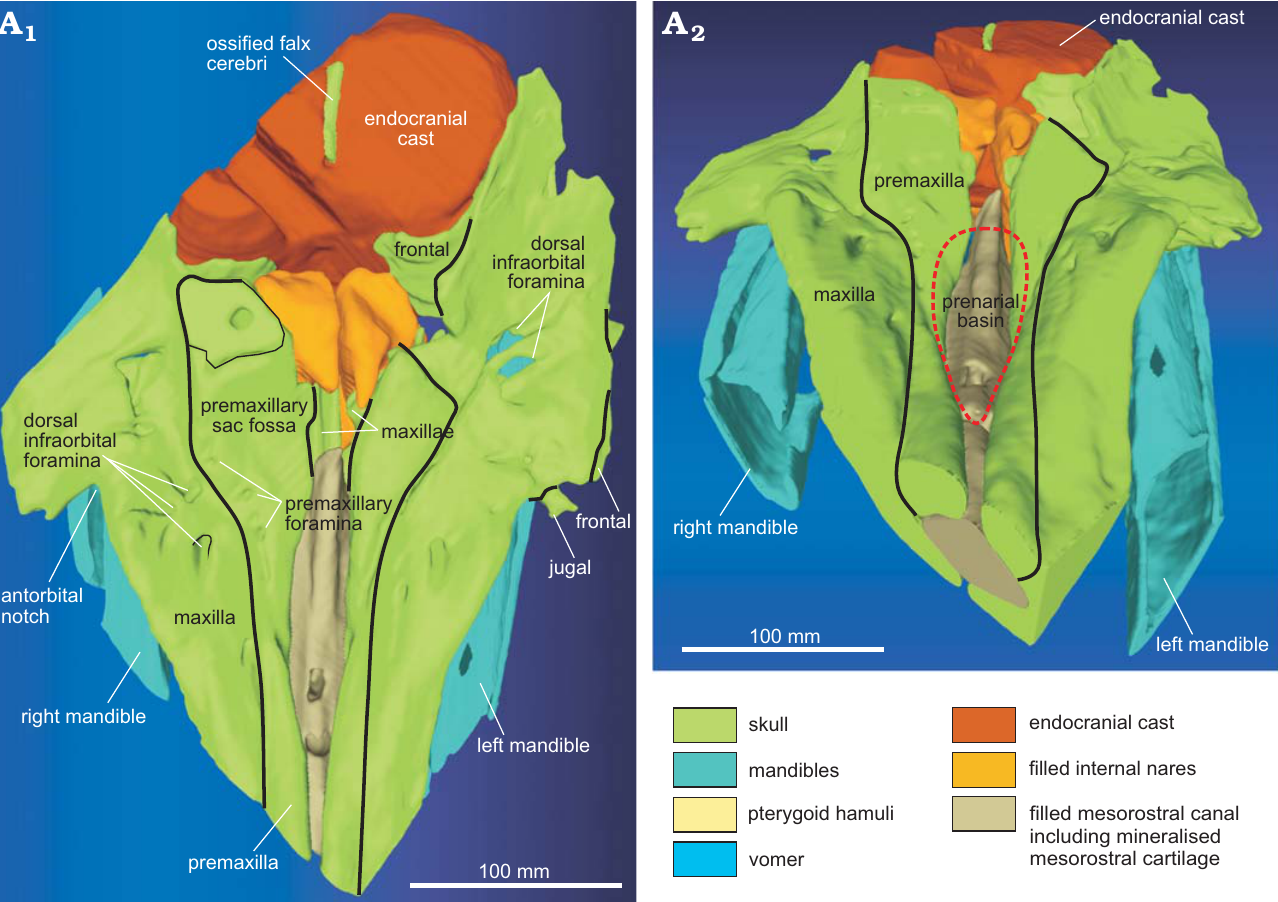
Fig. 3. 3D reconstruction resulting from the CT-scan of the ziphiid cetacean Messapicetus cf. longirostris Bianucci, Landini, and Varola, 1992 skull (MDM-2029) inside two limestone slabs from the Tortonian of Menorca (Balearic Islands, Spain), in dorsal (A 1 ) and anterodorsal (A 2 )